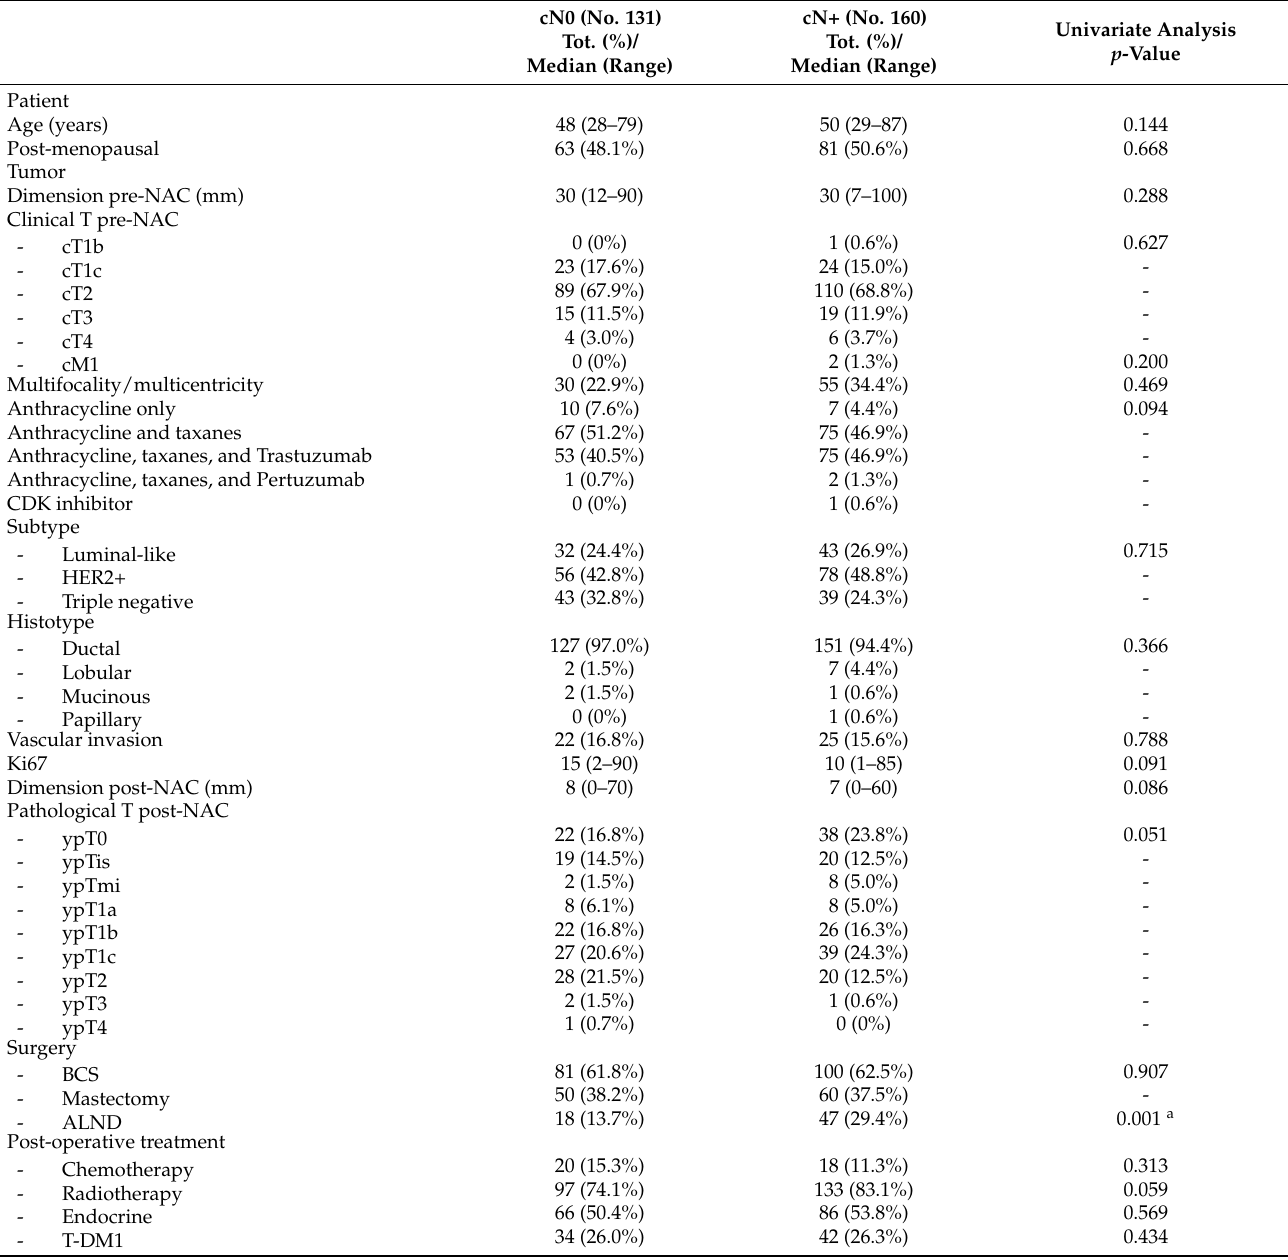
Table 1. Demographic, clinic-pathologic characteristics, and treatment data of breast cancer patients according to cN status prior to neo-adjuvant